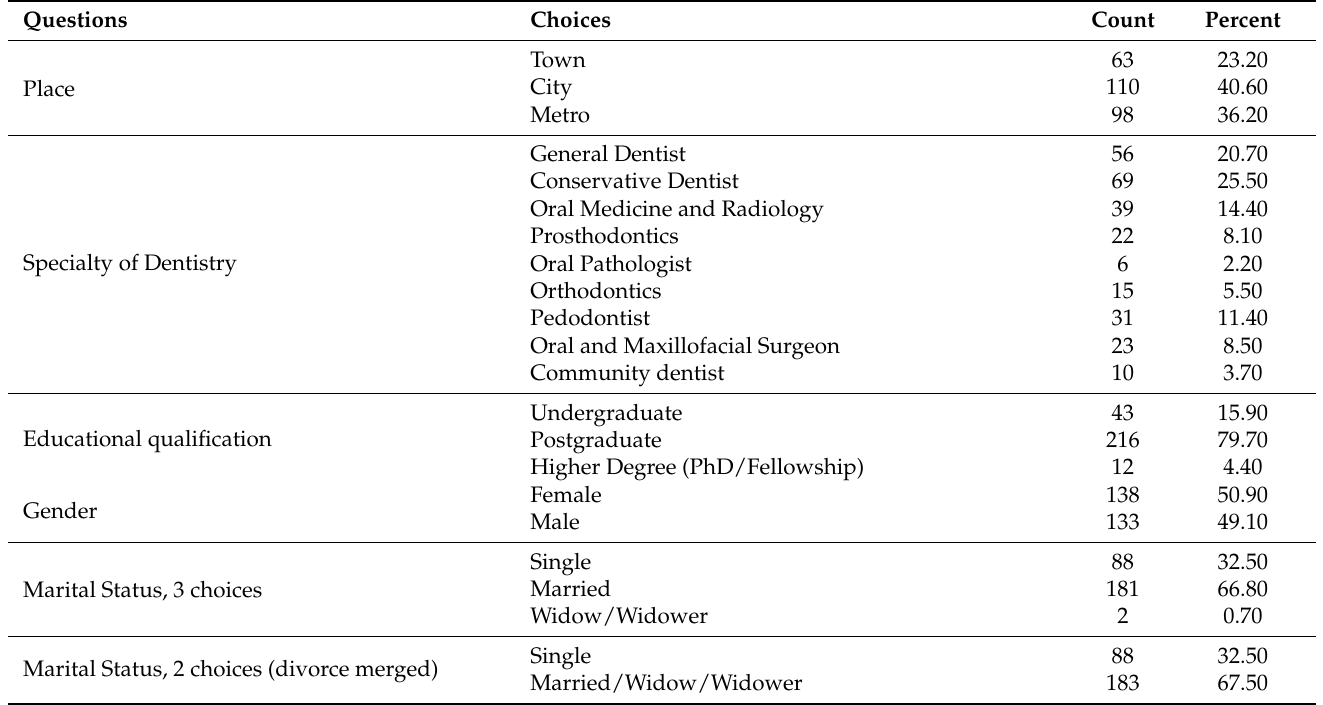
Table 1. Demographic, family, and professional details of the dental professionals who volunteered in the